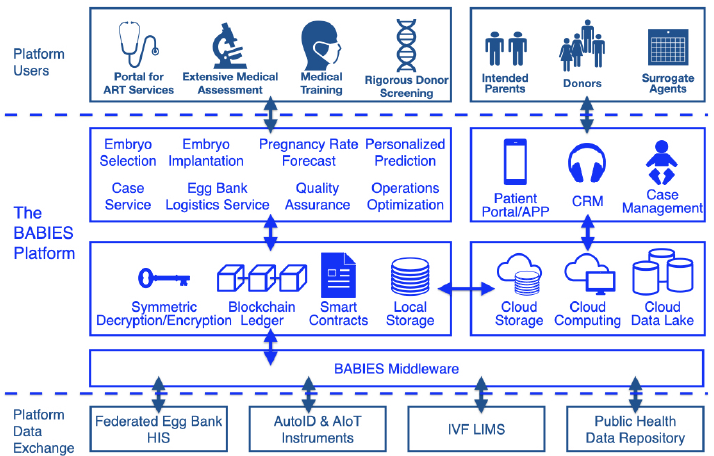
Figure 7. BABIES system